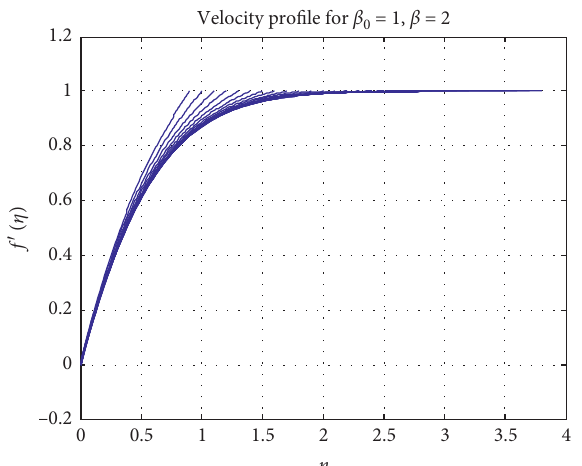
Figure 1: Velocity profile for ( β